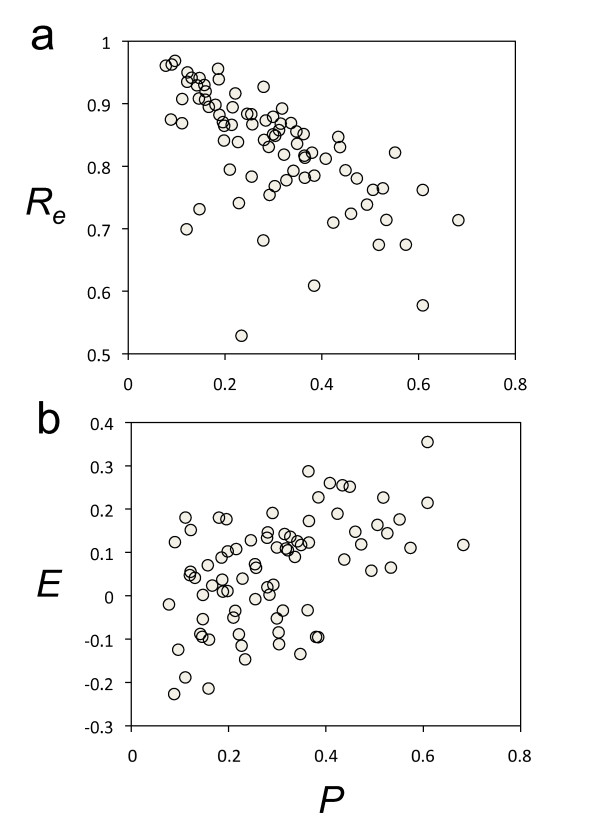
Plasticity correlates with environmental robustness and epistasis. (a) Scatter plot between plasticity (P) and environmental robustness (Re) for the bacterial sncRNAs. Spearman correlation coefficient = 0.396, P-value < 0.001. (b) Scatter plot between plasticity (P) and epistasis (E) for the bacterial sncRNAs. Spearman correlation coefficient = 0.728, P-value < 10-6.